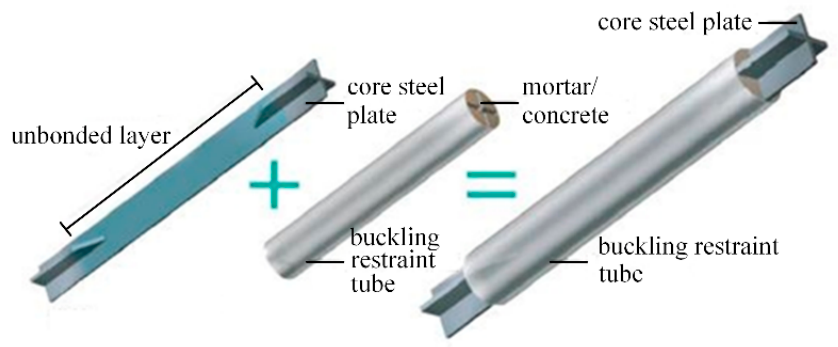
Figure 1. Buckling-restrained brace.